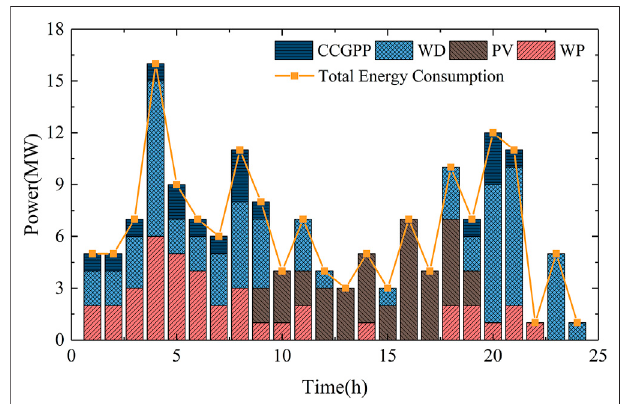
FIGURE 10 | Flue gas treatment energy consumption curve.